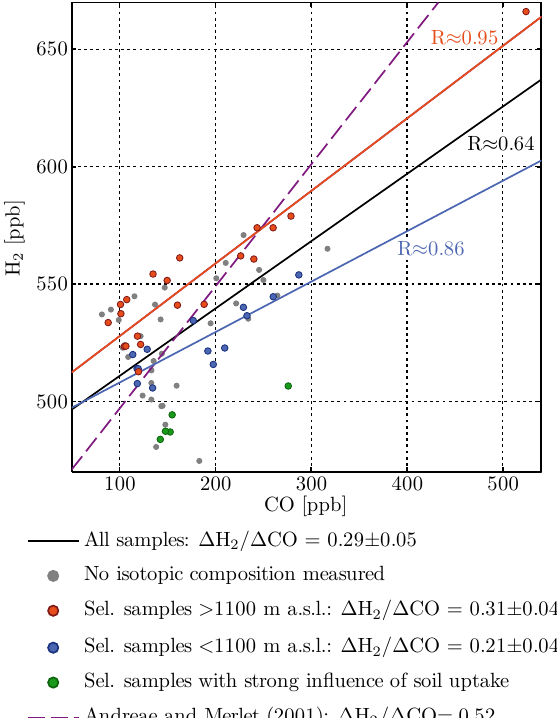
Fig. 2. Relation between H 2 and CO mixing ratios of BARCA-A samples. The bivariate total least squares regression line through all samples (coloured and grey) is shown in black. Those sam- ples where the H 2 isotopic composition was determined are shown in colour and all others are shown in grey. Coloured samples are separated in three groups: (red) high altitude samples (above 1100ma.s.l.) with biomass burning as major signal; (blue) low alti- tude samples (below 1100ma.s.l.) contaminated by biomass burn- ing but influenced by soil uptake; and (green) very low H 2 mixing ratio (not influenced by biomass burning). The slope of the bivariate total least squares regression line for all biomass burning influenced samples is also given. The purple dashed line shows the estimate of Andreae and Merlet (2001) for biomass burning in tropical rainfor-